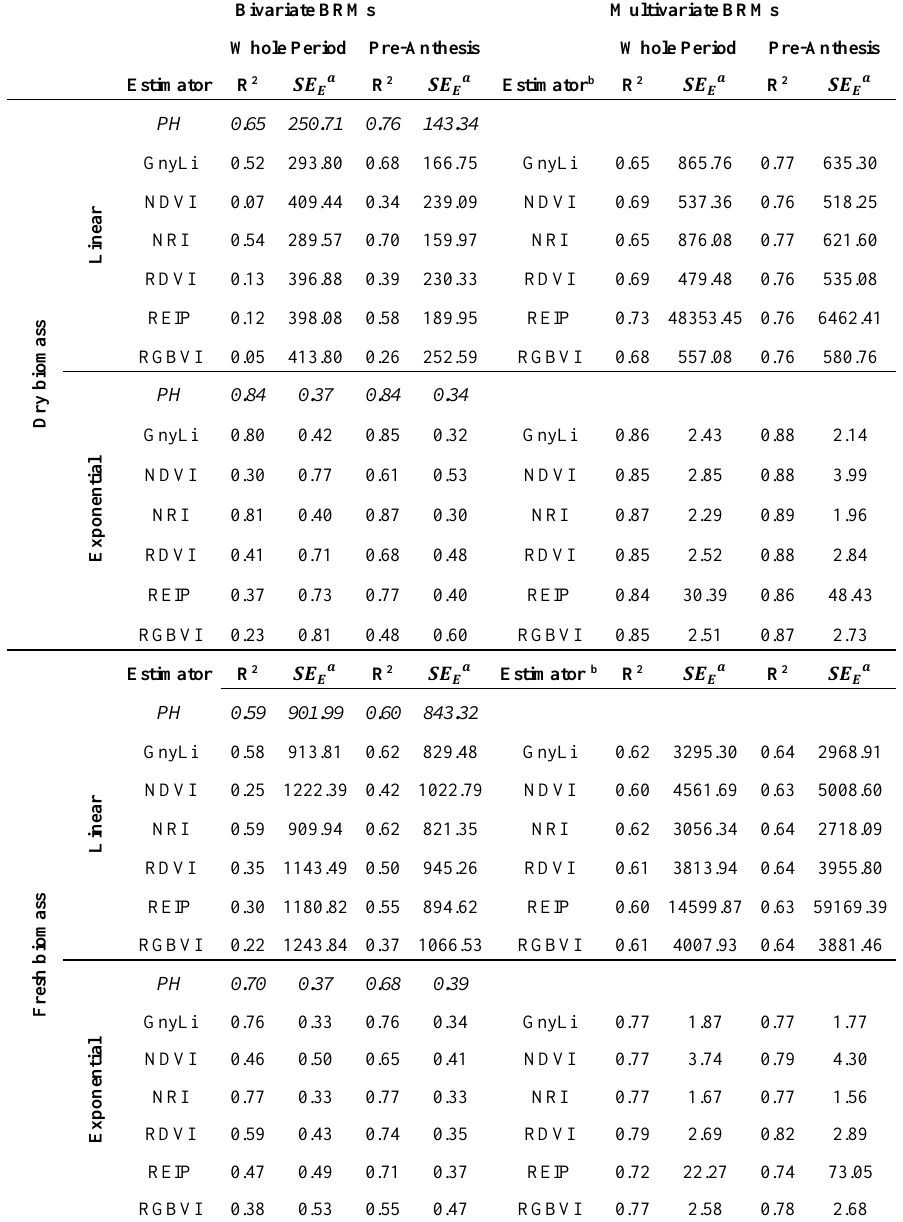
Table 5. Statistics for the model calibration as mean values of the four subset combinations (R 2 : coefficient of determination; SE E : standard error of the